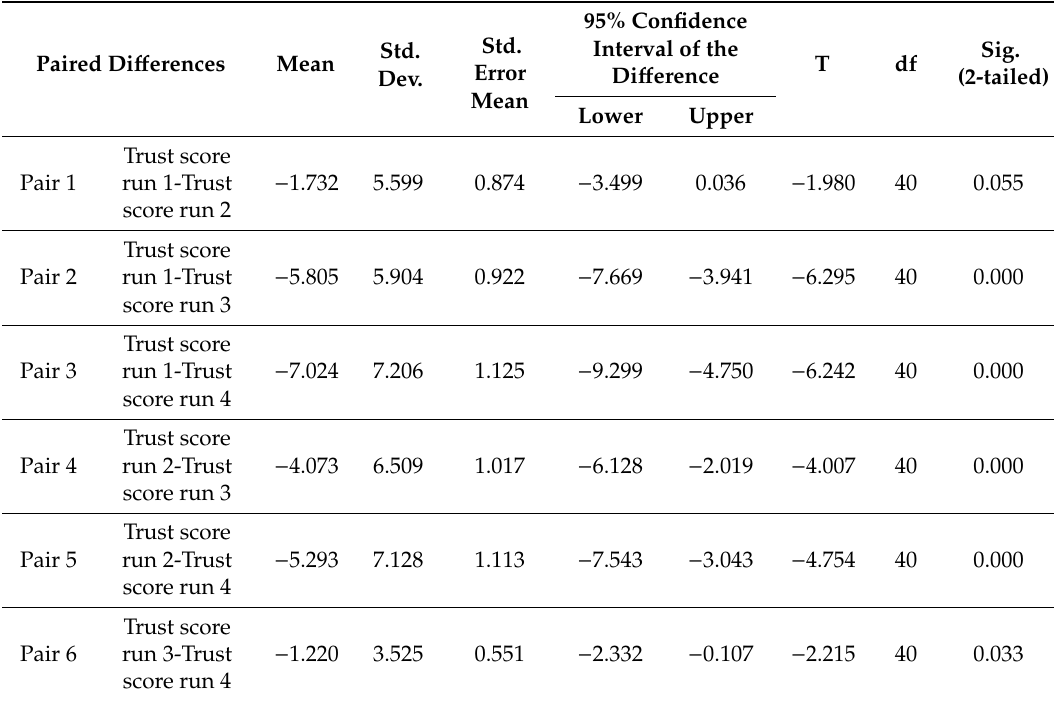
Table 2. Paired di ff erences in Jian et al. [75] scores between each journey in the vehicle.